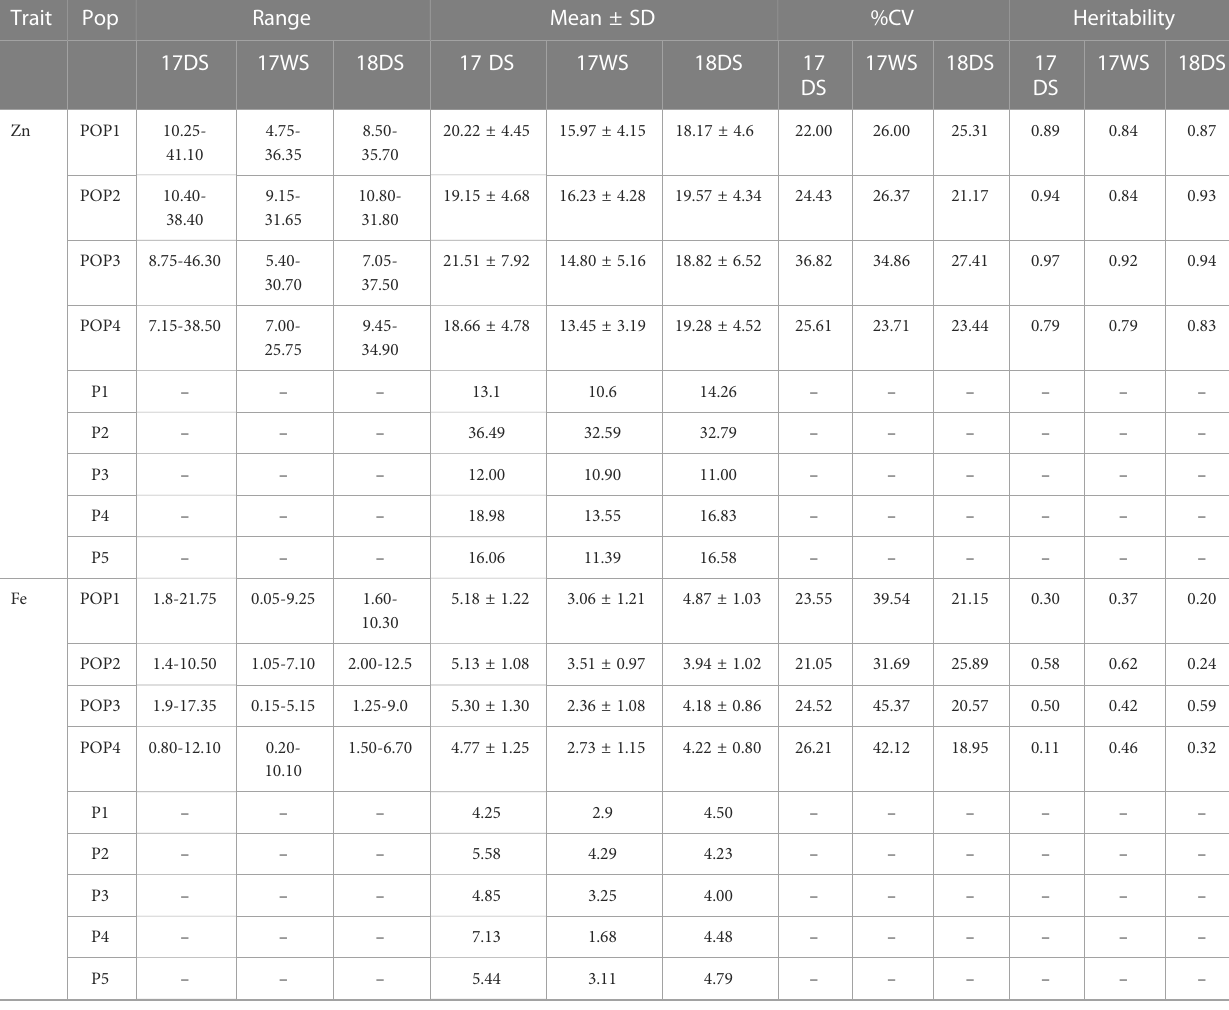
TABLE 1 Summary statistics of phenotypic traits of four RILs across seasons.